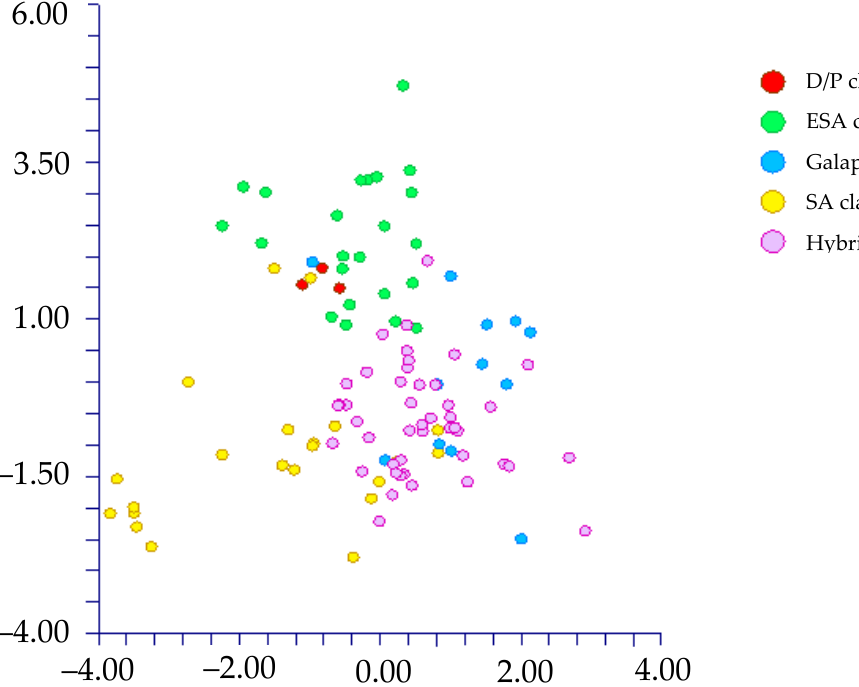
Figure 7. DA graph: [first (axis- x ) vs. second (axis- y ) component] performed on samples classified using Waselkov’s “molecular clades” [15] (nuclear genes).